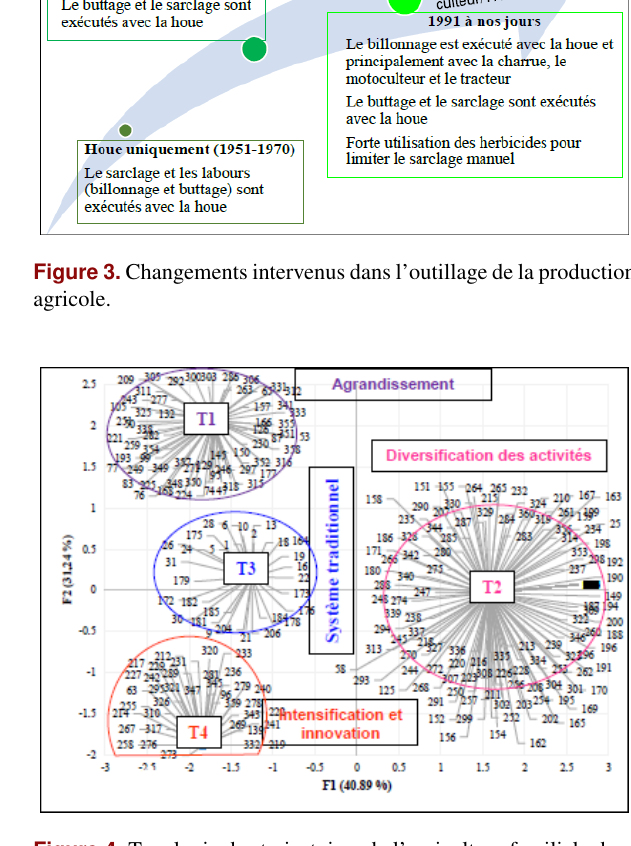
Figure 4. Typologie des trajectoires de l’agriculture familiale dans la